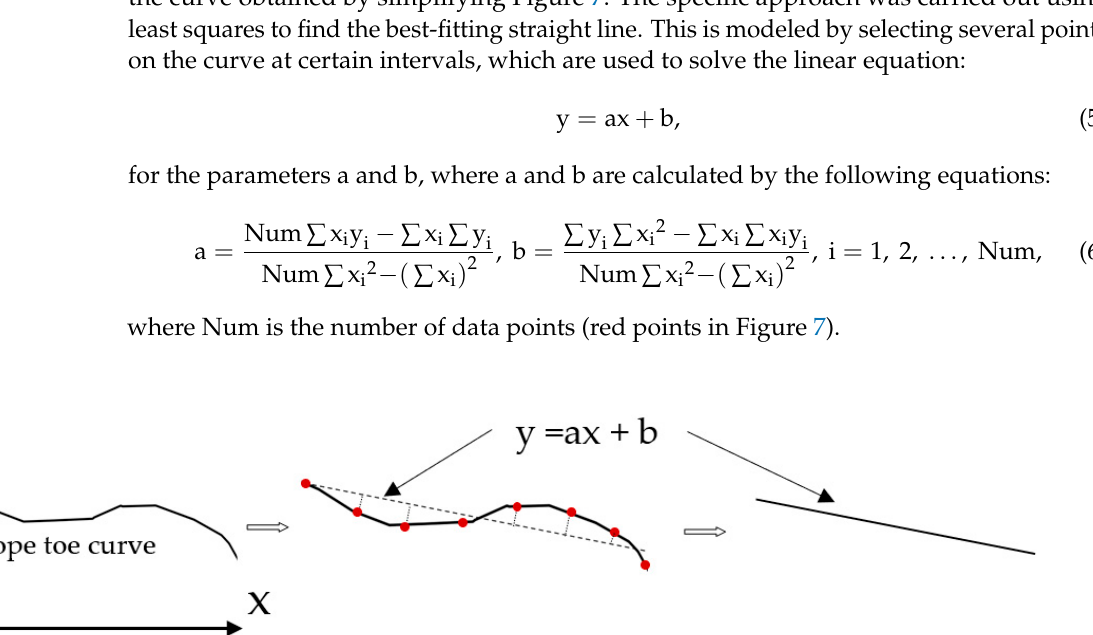
( b ) Figure 8. Camera sensor deployment in the X-direction: ( a ) the use of normal case photography and ( b ) the use of conver- gent photography to cover the entire mine surface. A represents the observed mine surface, the dotted line represents the photographic area, α represents the field of view, s(i) represents the camera monitoring point, and B represents the obser- vation platform. 2.4. The Optimum Deployment Algorithm The OCD4M algorithm is used to solve the camera sensor deployment problem. The algorithm starts with the input of camera sensor parameters, mine face parameters, ob- servation platform parameters, and photographic distances. The next step is to simplify the corresponding mine face in conjunction with the mining extent. Next, we calculate the minimum quantity of cameras and the coordinates through the algorithm. Therefore, the workflow of the algorithm is as shown in Figure 9.